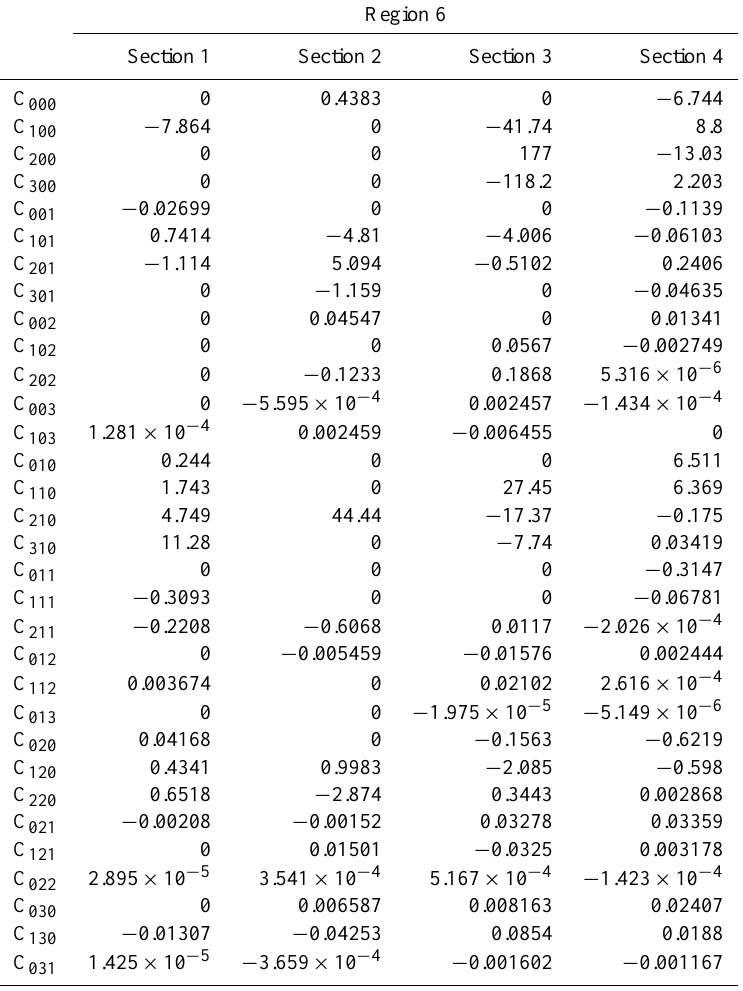
Table 8. Similar to Table 3, but for region